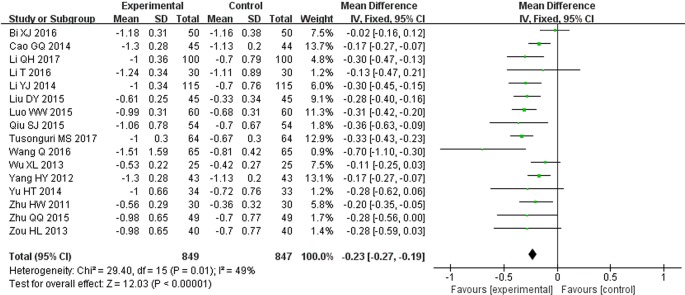
Meta-analysis for comparison of 24 h urinary protein levels between the experimental and control groups.